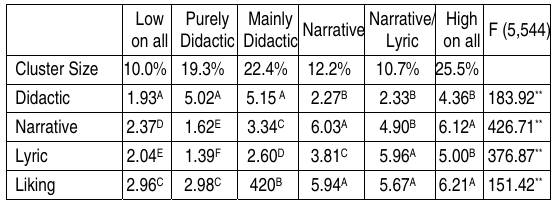
Fig. 2. The Structural model with path coefficients Table 3. The results of testing the proposed Table 5. Cluster means and corresponding ANOVA